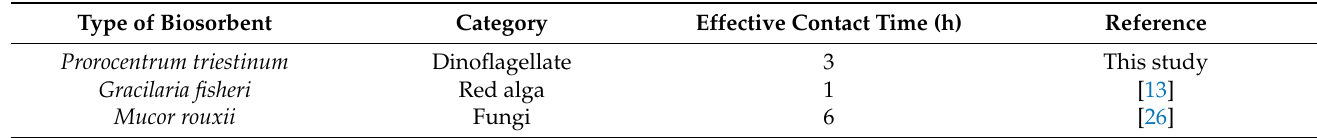
Table 5. Comparison of effective contact time with other biosorbents on Cd.